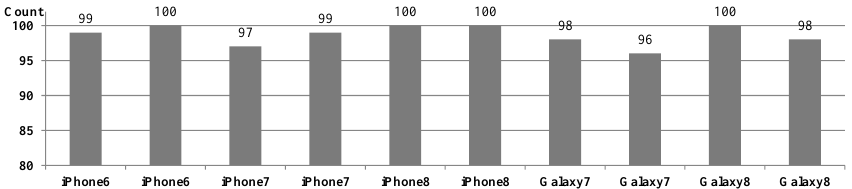
Fig. 6. Accuracy of detecting high frequency pairs by each smart